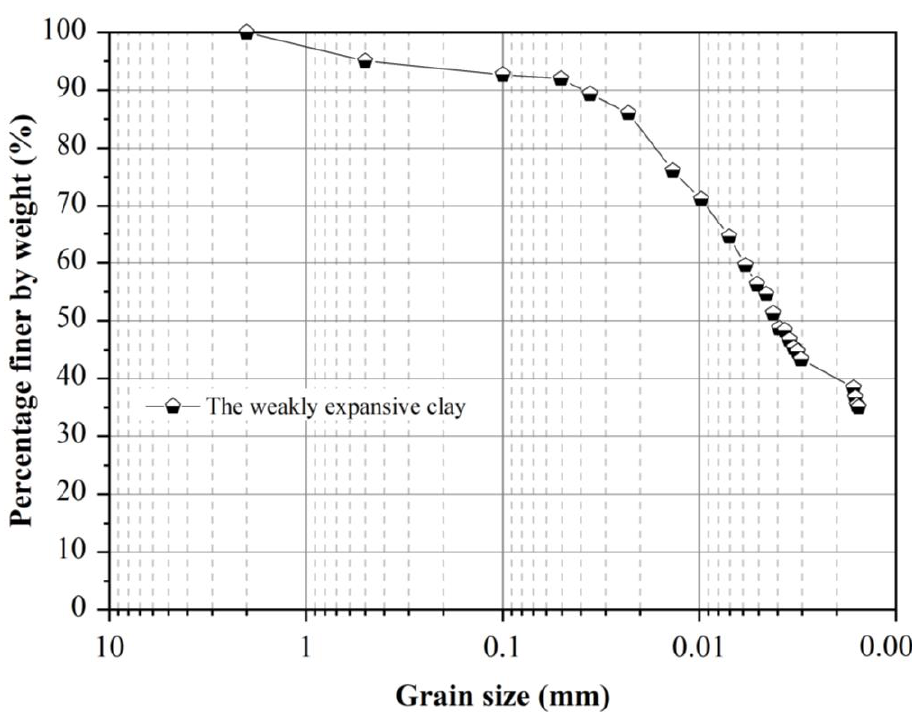
Figure 4. Particle size distribution of the soil in field tests.